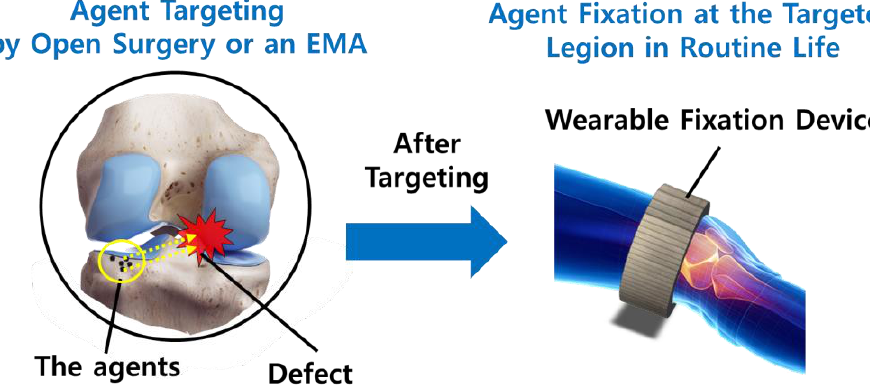
Figure 1. Schematic of a wearable fixation device for a magnetically controllable therapeutic agent carrier (MCTAC) with magnetic nanoparticles (MNPs) after targeting therapeutic agents onto the defect lesion.